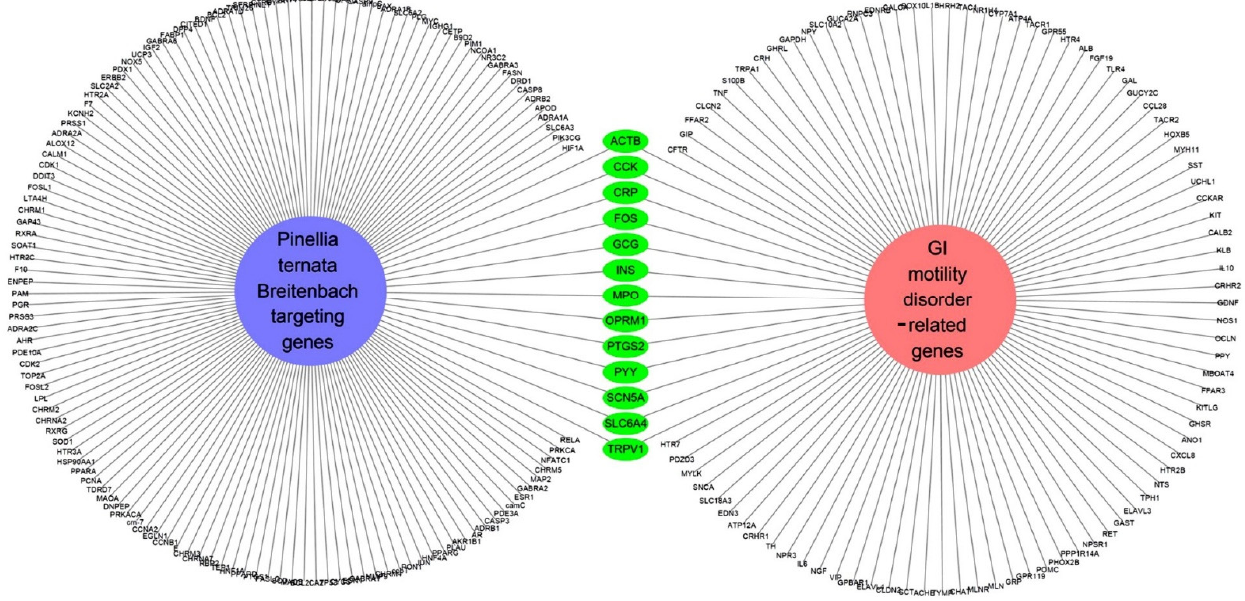
Figure 4. Network of gastrointestinal motility disorder-related genes and Pinellia ternate Breitenbach -targeting genes. The 13 genes included in both “genes related to gastrointestinal motility disorder” and “ Pinellia ternate Breitenbach -target genes” are collected in the center.